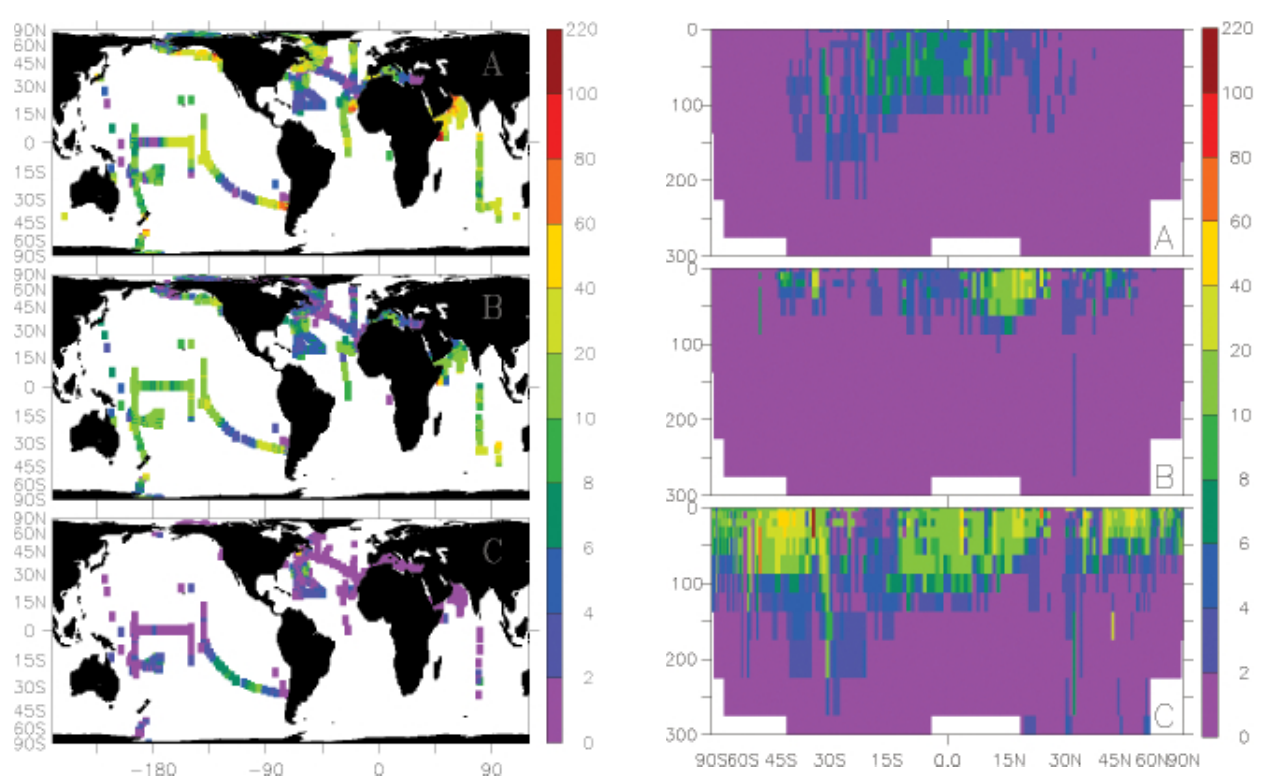
Figure 4. Picophytoplankton biomass [ µ gCl − 1 ]. (A) 0–40m,